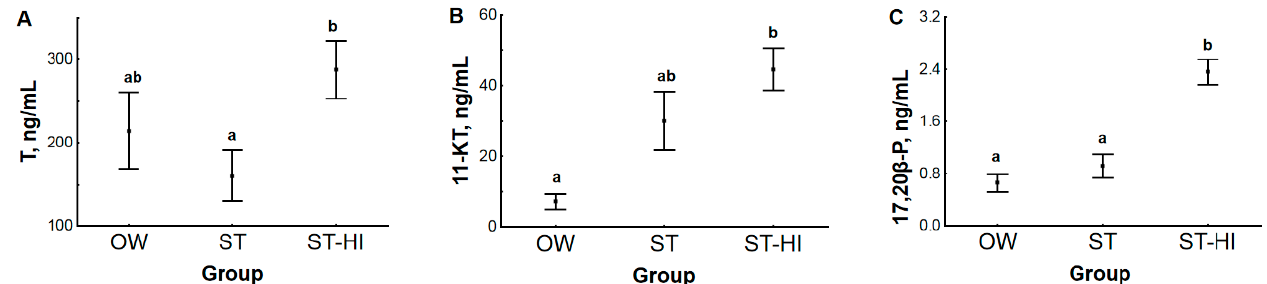
Figure 4. Blood plasma level of: ( A ) testosterone (T, ng/mL), ( B ) 11-ketotestosterone (11-KT, ng/mL), ( C ) 17,20 β -dihydrox- ypren-4-en-3-one (17,20 β -P, ng/mL) in experimental groups of sterlet. OW—fish were held in fish-farming ponds (water temperature 2 °C); ST—fish were adapted to spawning temperature of 14 °C, spermiation was not induced; ST-HI—fish were adapted to spawning temperature of 14 °C, spermiation was induced. Dots represent the means, and whiskers rep- resent the standard errors. Values with different letters are significantly different (for T and 17,20 β -P, p < 0.05, Tukey’s HSD test, and for 11-KT p < 0.05, multiple comparisons of mean ranks for all groups).